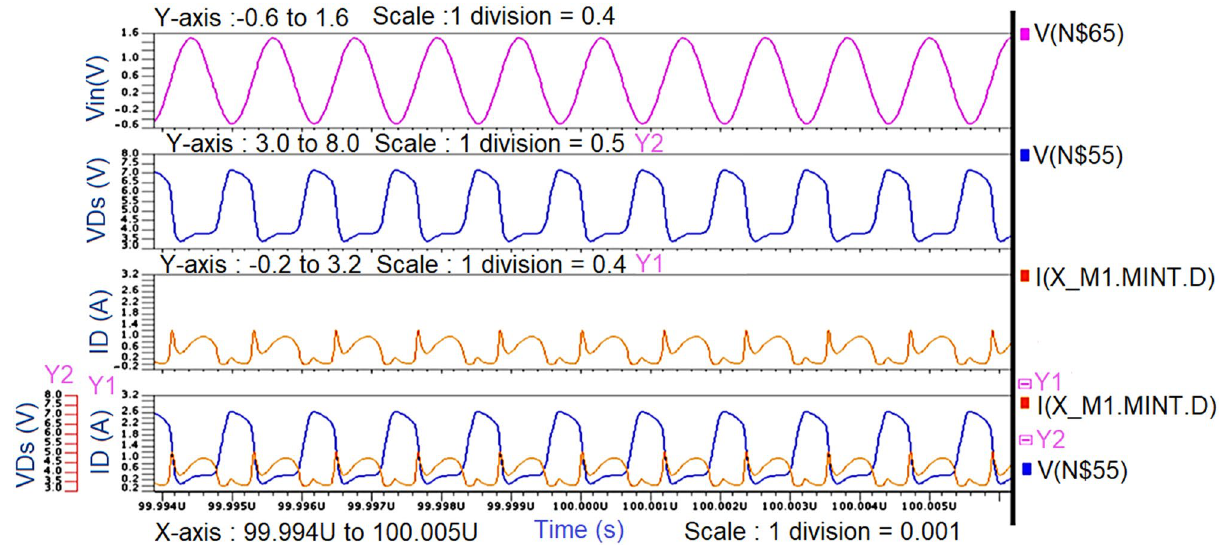
Figure 10. Transient response of Class-J PA with sinusoidal input source at 850 MHz.